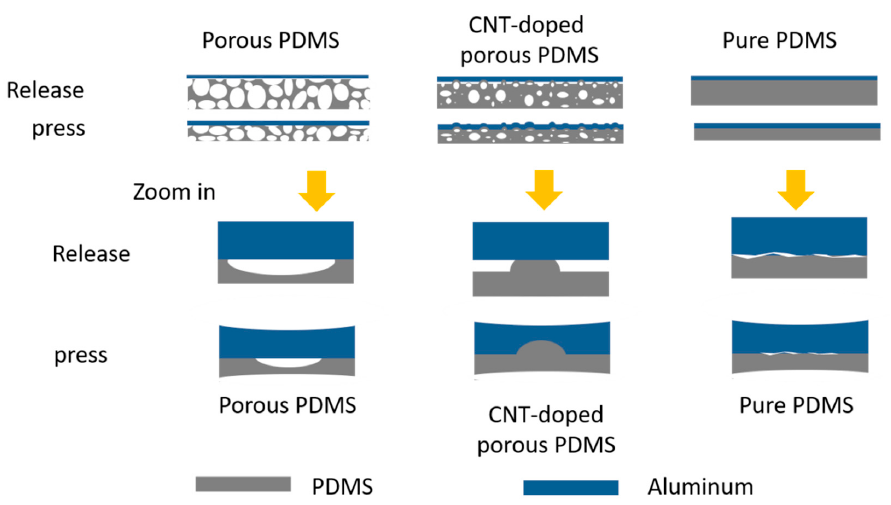
Figure 4. ( a ) Contact-separation mode of CNT-doped porous PDMS sample; ( b ) contact-separation Figure 4. Schematic of contact-separation mode for different PDMS mode of the undoped porous PDMS sample.